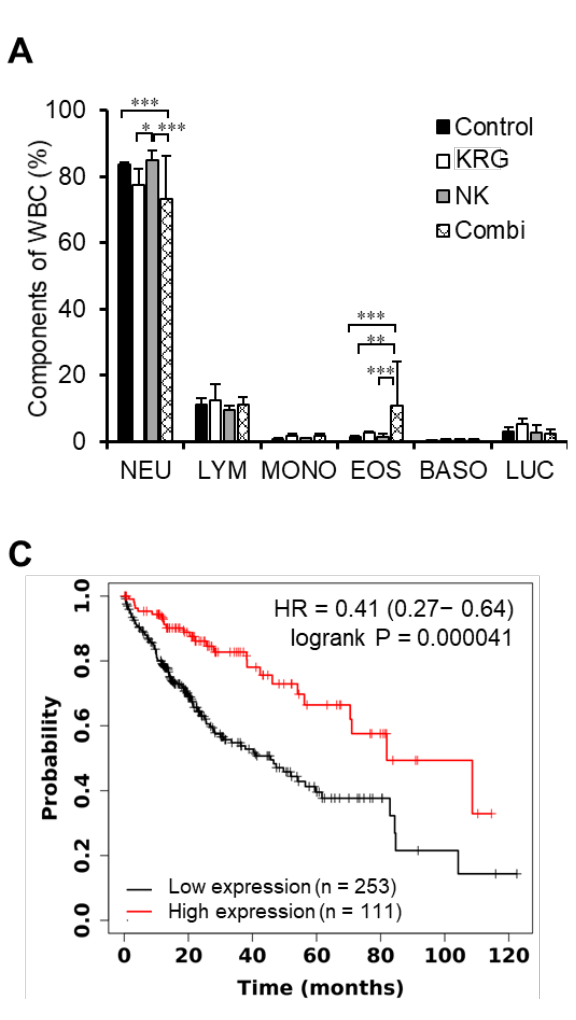
Figure 4. Activation of IL33 related to eosinophils in an experimental metastasis model. ( A ). Ratio of white blood cell (WBC) components. Data are expressed as the mean ± standard deviation ( n = 3/group). *, p < 0.05; **, p < 0.01; ***, p < 0.005. (two-way ANOVA with Tukey’s post hoc test) ( B ). Expression of IL33, MBP, and IFN γ levels in metastatic liver tissues. ( C ). Kaplan–Meier curve of liver cancer patients with high ( n = 111) and low ( n = 253) IL33 expression.